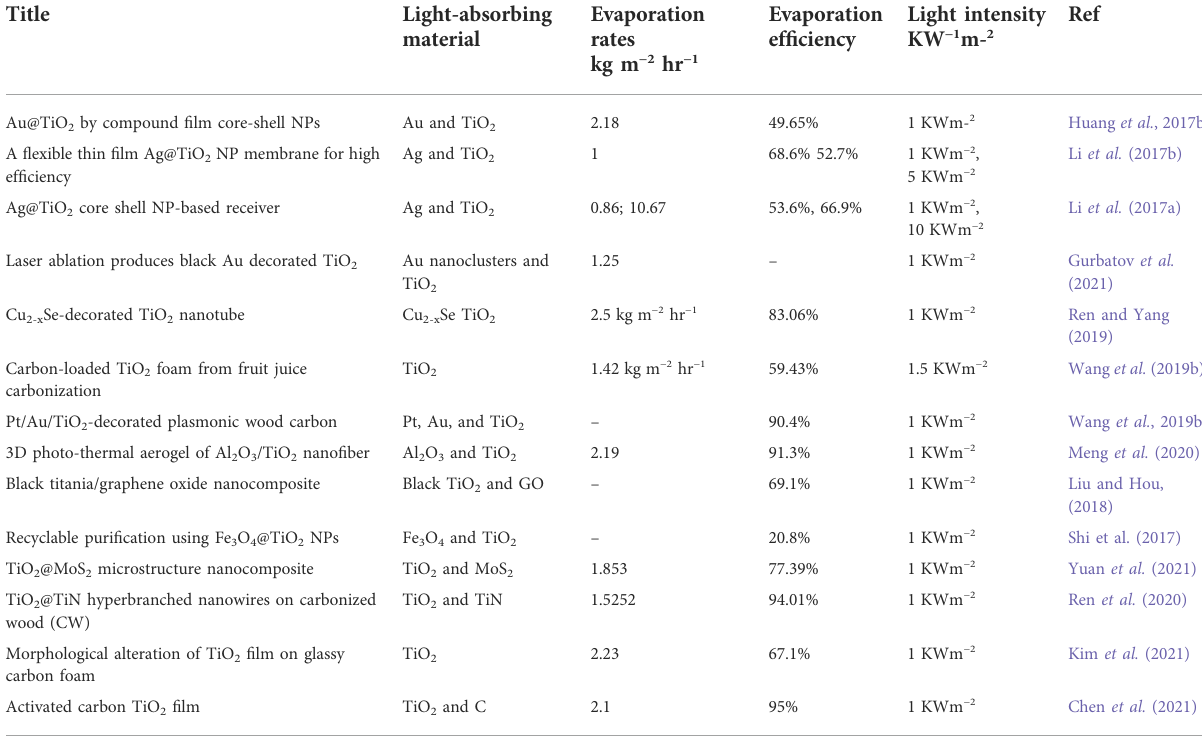
TABLE 2 Solar evaporation rates and ef fi ciencies of various hybridized TiO 2